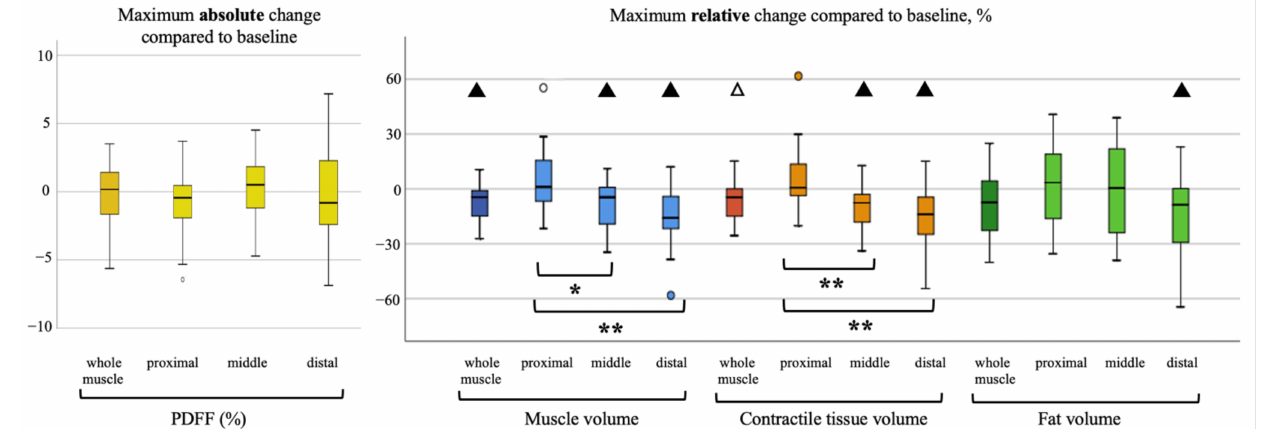
Figure 4. Visualization of absolute maximum change of M. erector spinae PDFF on the left, relative maximum change of muscle volume, contractile tissue volume and fat volume per proximal, middle and distal muscle section on the right. Statistical significance of change tested with one-sample t -test (compared to no change with test value = 0), (cid:52) = <0.05, (cid:78) = <0.01. Statistical significance of change differing between muscle sections tested with one-way ANOVA analysis, * = <0.05, ** = <0.01. Table 3. Correlation of baseline total muscle and proximal, middle and distal muscle section muscle parameters and absolute maximum BMI change at follow-up. Correlations are based on Spearman ´ s rank correlation as variables did not present normal distribution. PDFF: proton density fat